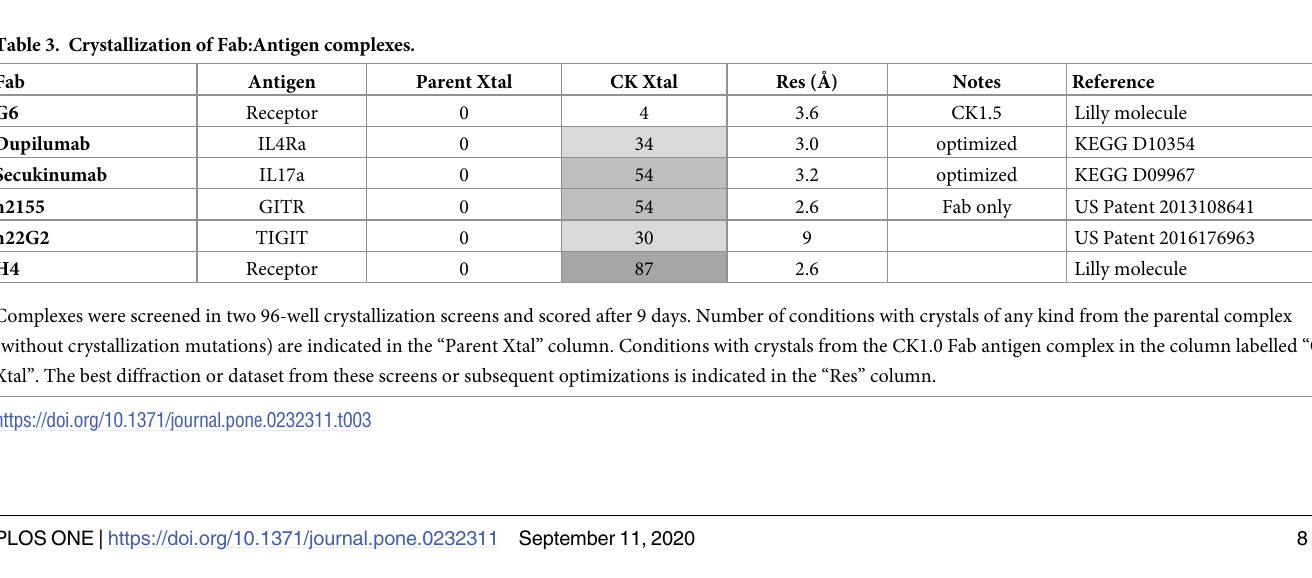
Table 3. Crystallization of Fab:Antigen complexes.